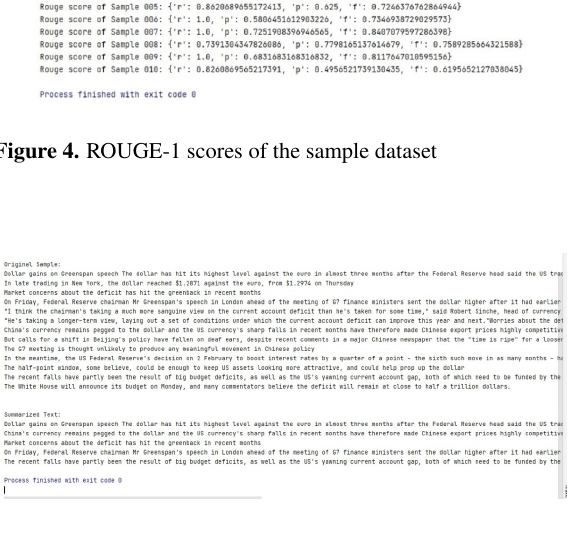
Figure 5. Sample input and its summarized